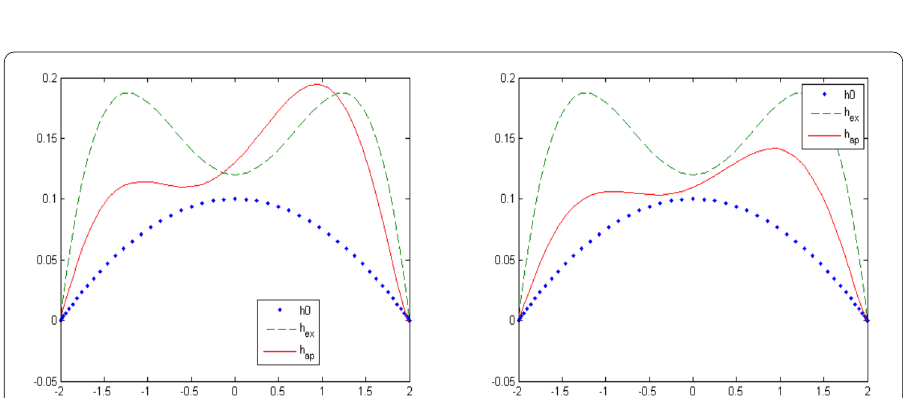
Figure 8 Reconstruction of h 2 for δ = 0.05 (left), for δ = 0.1 (right)